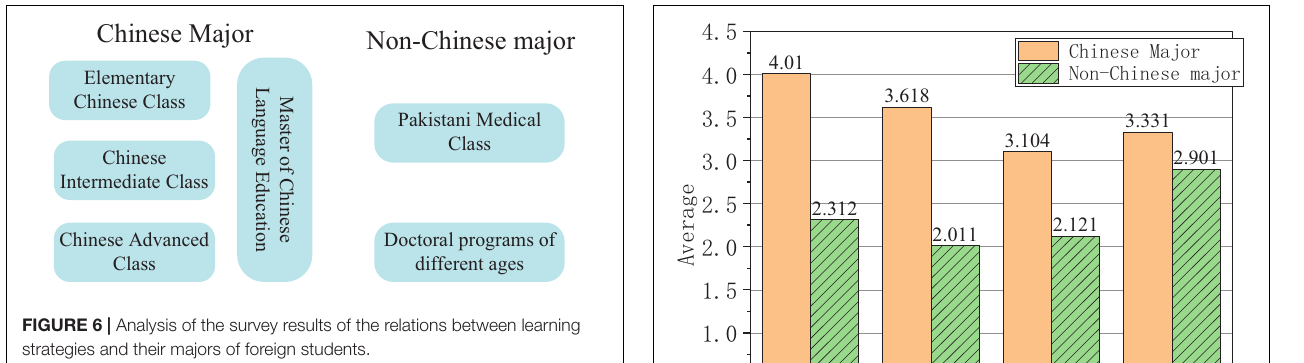
strategy more frequently, and almost everyone can alleviate their anxiety and pressure in Chinese learning.